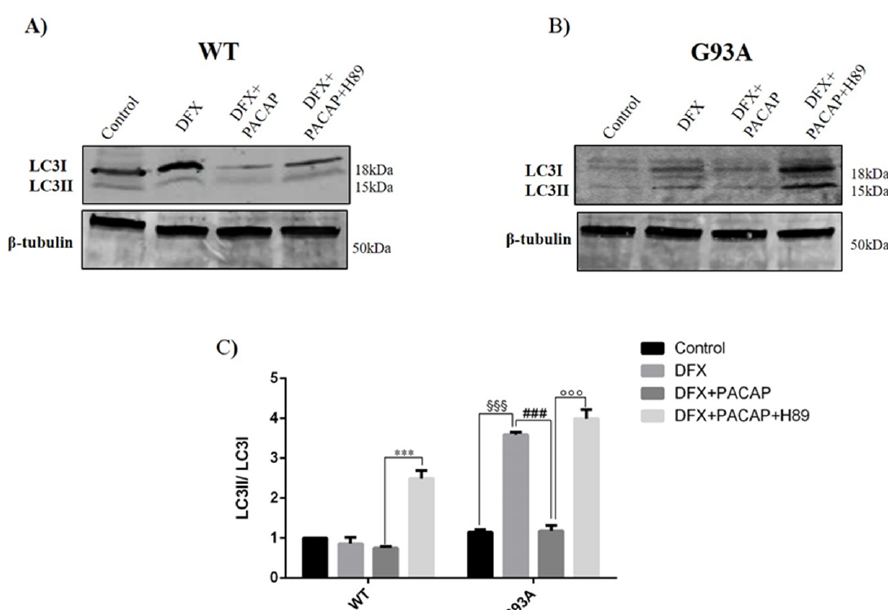
Figure 7. PACAP a ff ects the LC3II expression levels in the WT and G93A cells through the activation of MAPK / ERK signaling. ( A , B ) Representative immunoblots of the signals detected by the LC3I-LC3II antibody on the WT and G93A cell homogenates cultured for 24 h in desferrioxamine mesylate salt (DFX) alone or in combination with PACAP (DFX + PACAP) or PACAP + H89 (DFX + PACAP + H89). ( C ) The bar graph shows the results of three independent experiments. Relative band density was quantified by the ImageJ software and the protein levels are normalized to LC3I. β -tubulin was used as a loading control. Data are expressed as a mean ± SEM of values normalized to the WT / control data set to 1.0 ( §§§ p < 0.001 vs. G93A control, ### p < 0.001 vs. G93A DFX, *** p < 0.001 vs. WT DFX + PACAP or °°° p < 0.001 vs. G93A DFX + PACAP as determined by one-way a ANOVA followed by Tukey's post-hoc test).